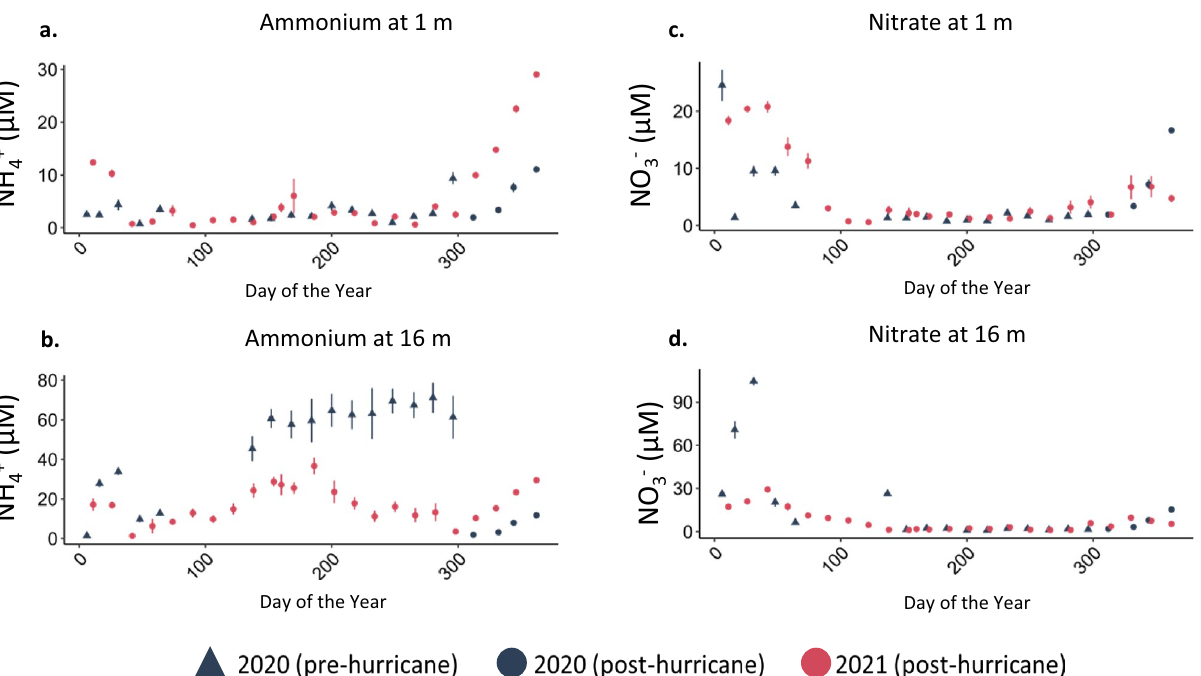
Figure 6. (a ) Surface NH 4+ , ( b ) deep NH 4+ , ( c ) surface NO 3− , and ( d ) deep NO 3− at five continuously monitored in-lake locations (mean ±